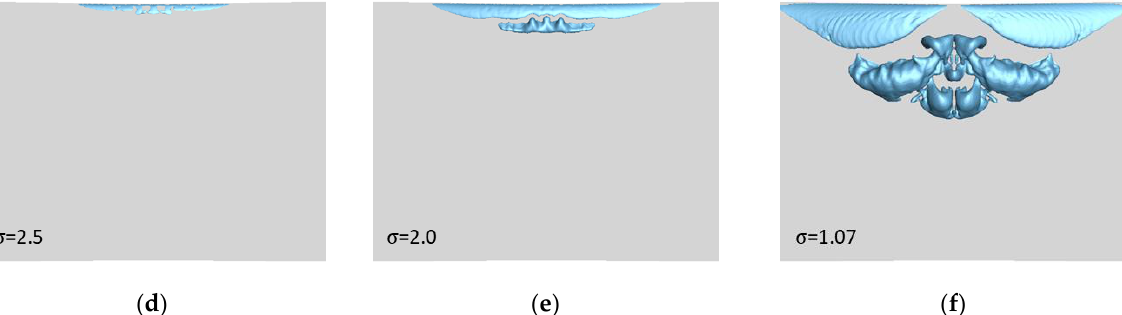
Figure 16. Cavitation features according to cavitation number. From ( a – f ), the cavitation number is 4.17 – 1.07 (experiment condition).